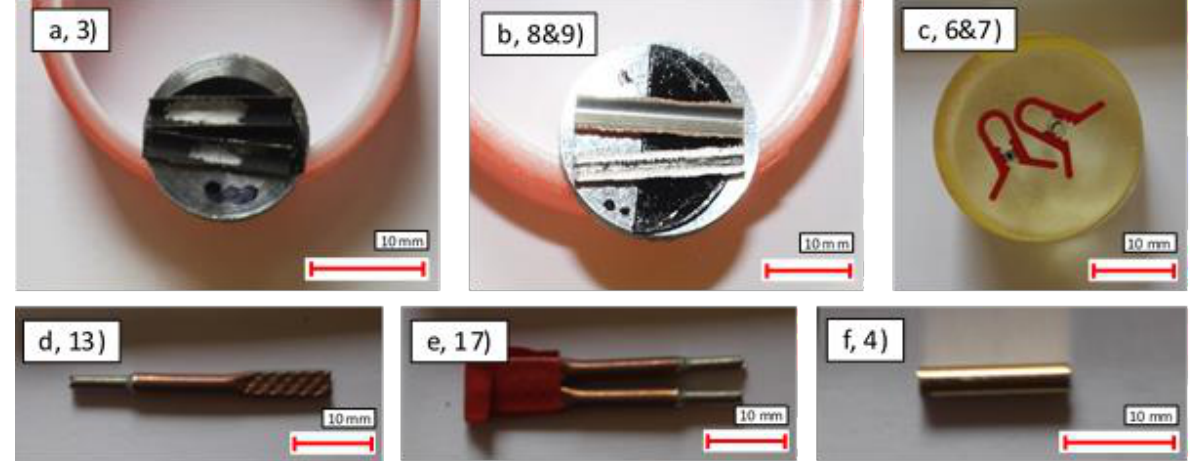
Table 1. List of uncoated and coated samples with sample dimensions.